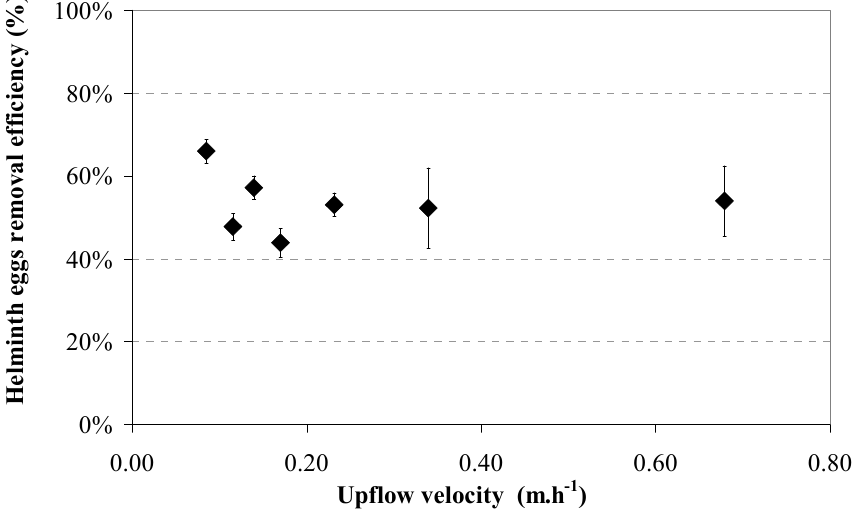
Figure 8. Helminth egg removal efficiencies ( ♦ ) versus upflow velocity without sludge in the control experiment. Results shows the average of three samples and standard deviation; no sludge bed.